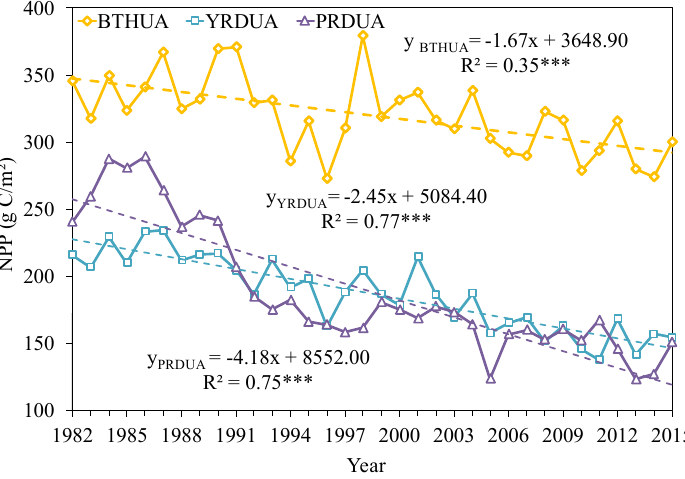
Figure 8. NPP trends between 1982 and 2015 in the BTHUA, YRDUA, and PRDUA within urban lands in 2015. The mark (***) indicates relative levels of significance with p < 0.001.